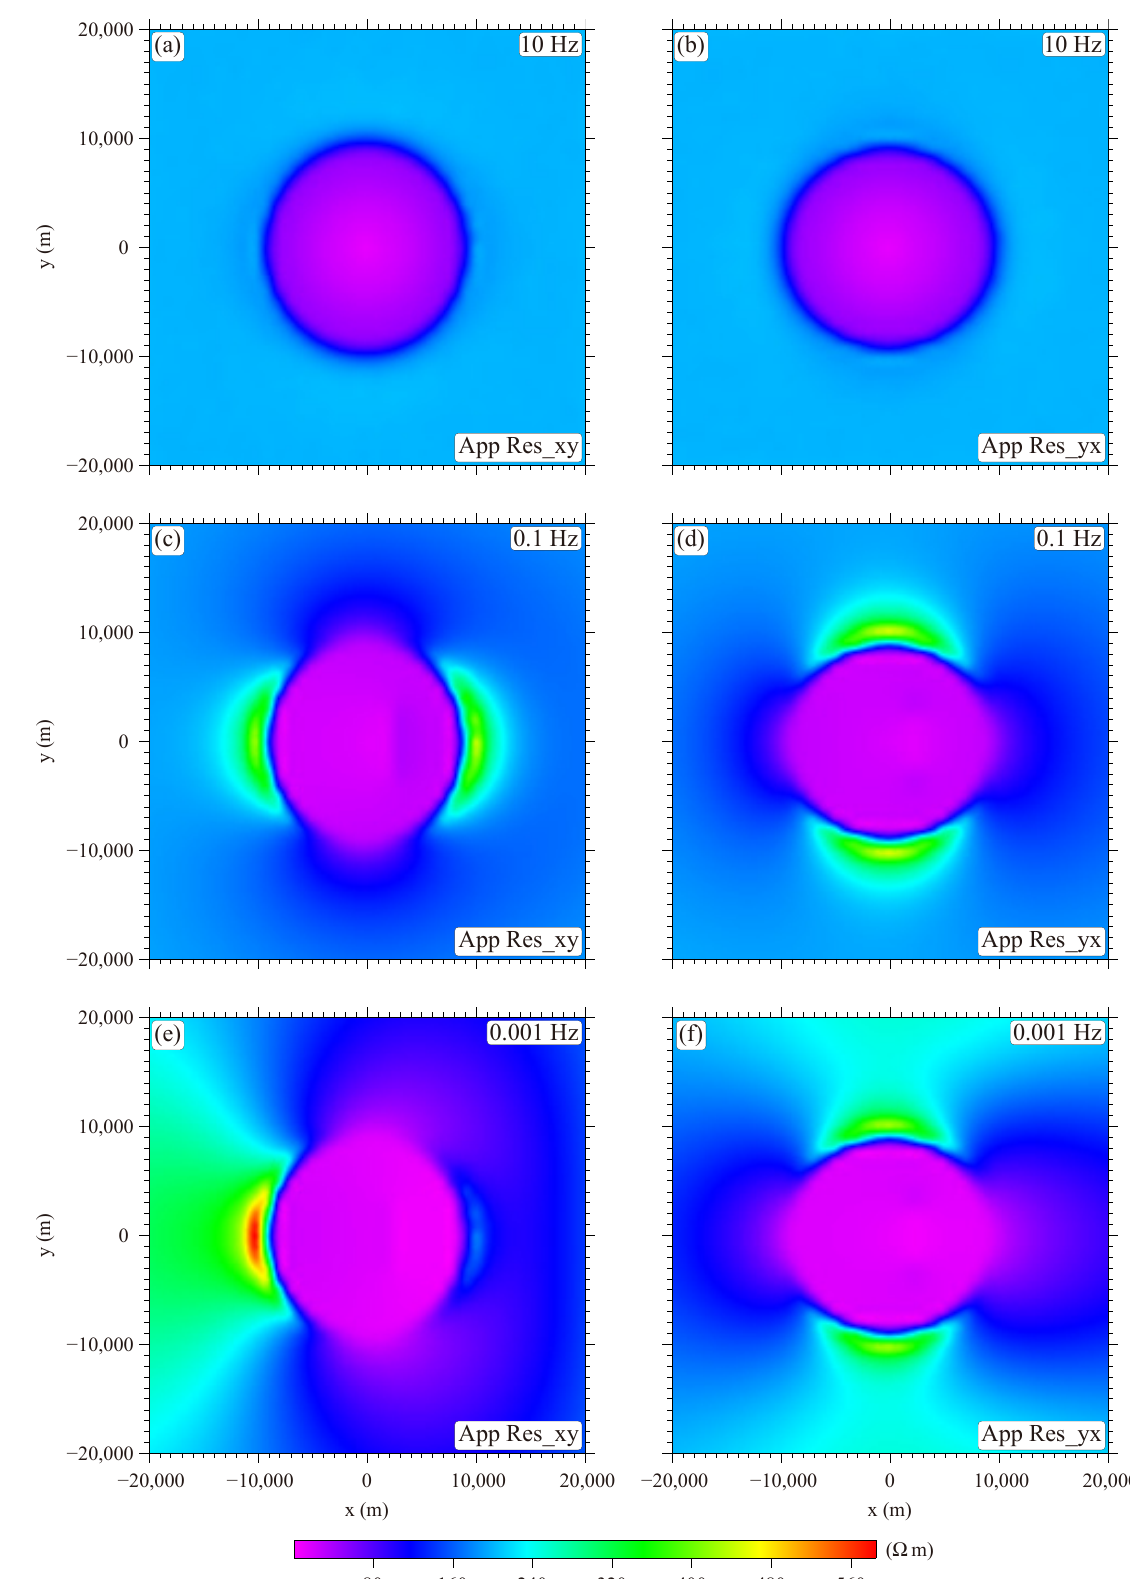
Figure 15. The contour maps of the apparent resistivities for the HDR and partial melting system, as shown in Figure 13. ( a , b ) are for 10 Hz, ( c , d ) are for 0.1 Hz, and ( e , f ) are for 0.001 Hz.